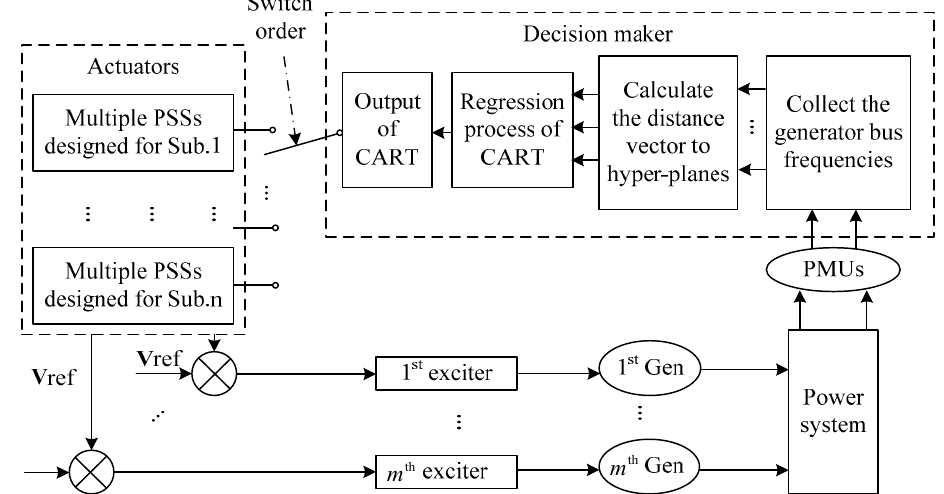
Figure 5. Configuration of the proposed adaptive damping control scheme.